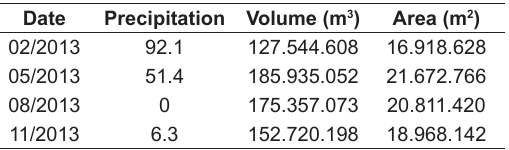
Table 2. Monthly water indexes, Precipitation (mm), Volume (m 3 ) and Area (m 2 ) of the Umari reservoir, Rio Grande do Norte, Brazil, in the year 2013.